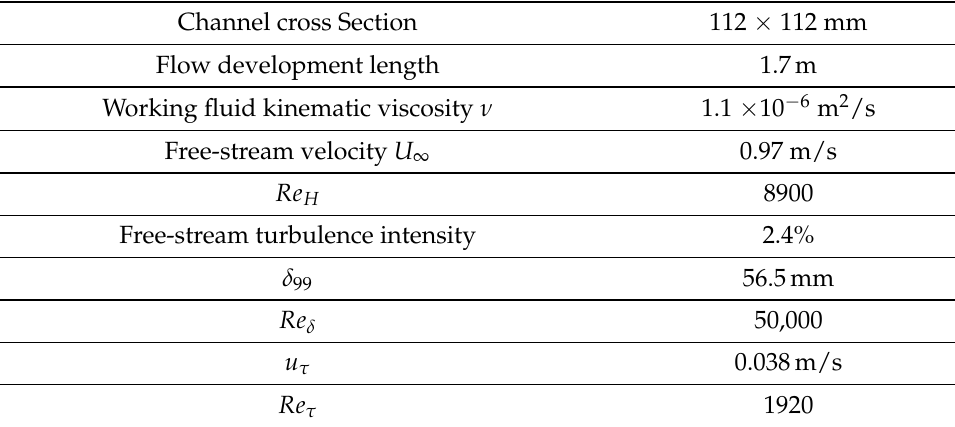
Table 2. Characteristics of the incoming flow for the highest Re case ( Re H =